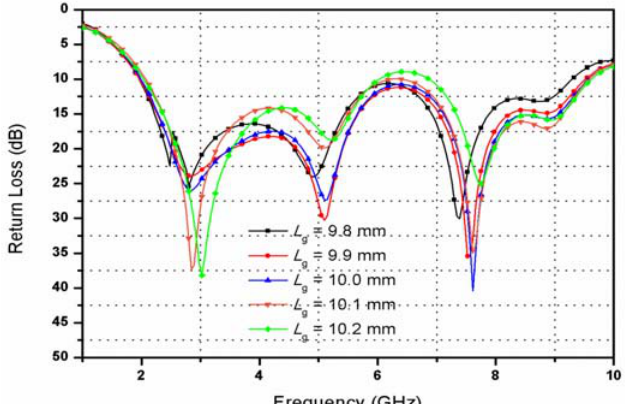
Figure 5: Simulated return loss against frequency for the octagonal ring shape ultra wideband antenna with various : other parameters are the same as listed in Table 1. L g